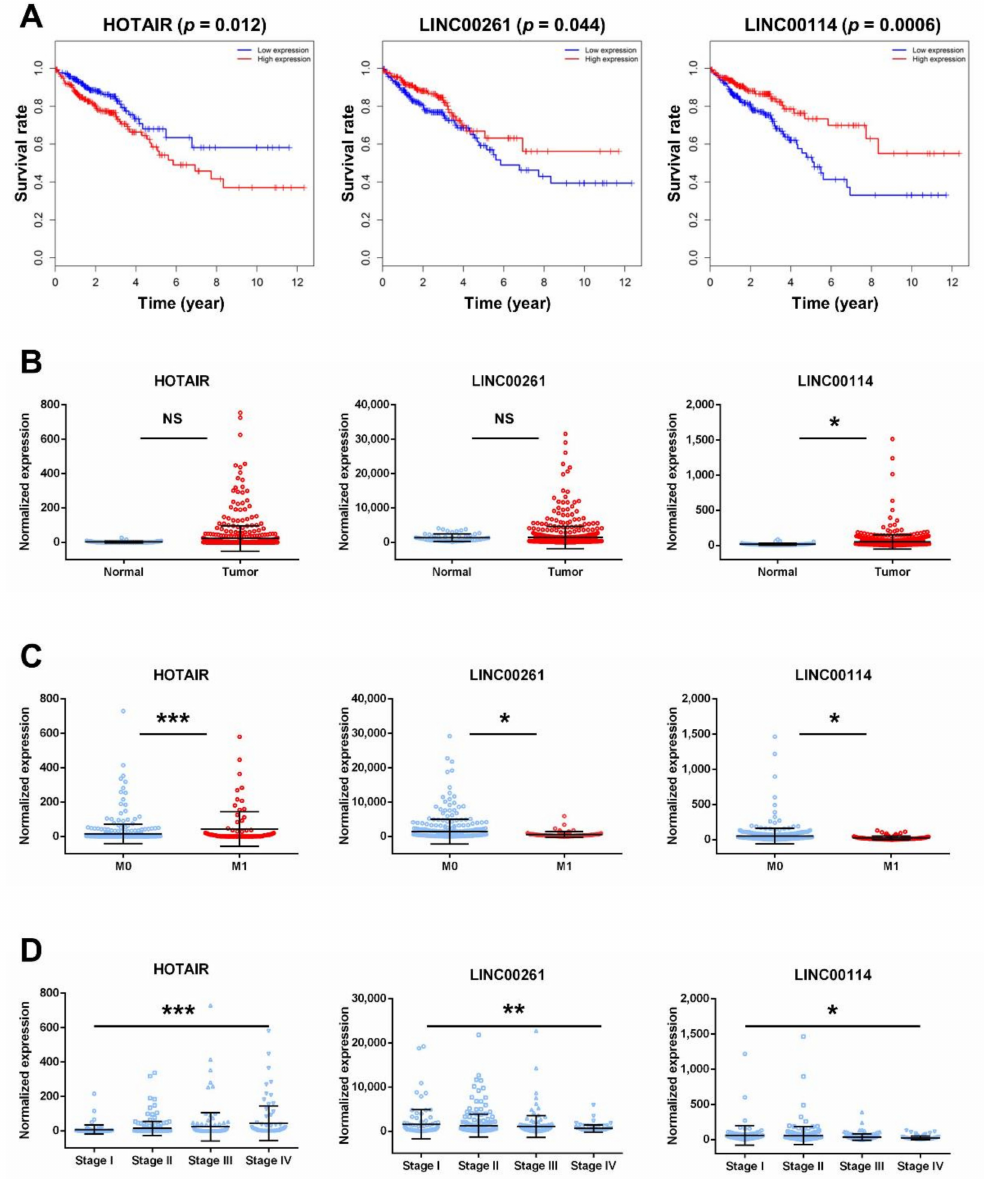
Figure 5. Clinical feature analysis of HOTAIR, LINC00261, and LINC00114. ( A ) Kaplan–Meier analysis of CRC overall survival according to the three lncRNAs. Percent survival is shown on the y -axis, and time is shown on the x -axis. Red lines represent patients with higher expression levels of lncRNAs, and blue lines represent patients with lower expression levels of lncRNAs ( p < 0.05 log-rank test). ( B ) LncRNA expression analysis in CRC tissues and normal tissues. ( C ) LncRNA expression analysis in metastatic CRC tissues (M1) and nonmetastatic samples (M0). ( D ) LncRNA expression analysis in stages 1–4 of CRC. Significant di ff erences were assessed by nonpaired t -tests. n.s., not significant; * p < 0.05, ** p < 0.01, *** p <